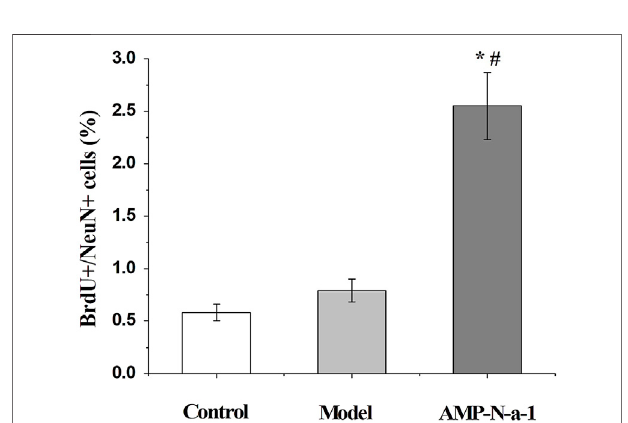
FIGURE 4 | Ratios of BrdU + /NeuN + cells in the control group, model group, and 0.1 g kg − 1 AMP-N-a-1 group. Notes: compared with those in the control group, * p < 0.05; compared with those in the model group, # p <